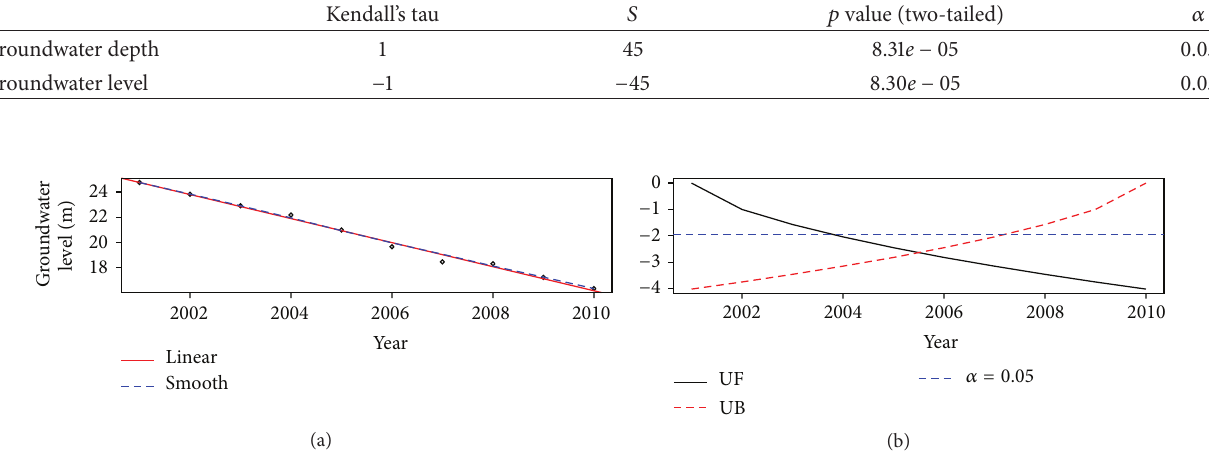
These variables were defined as follows. (i) Precipitation amount was averaged to the entire Beijing district based on the observed data of national individual rain gauge